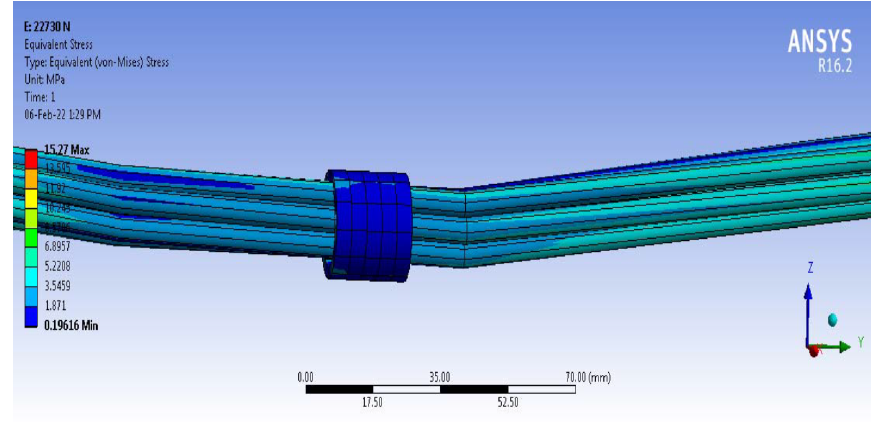
Figure 13. Phase I Equivalent Stress distributions on steel wire rope.